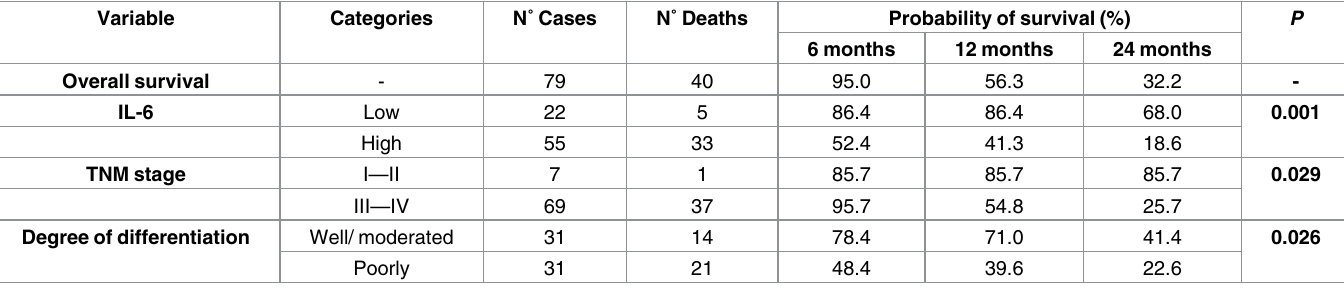
Table 3. Estimate of overall survival considering the clinical variables and plasma level of